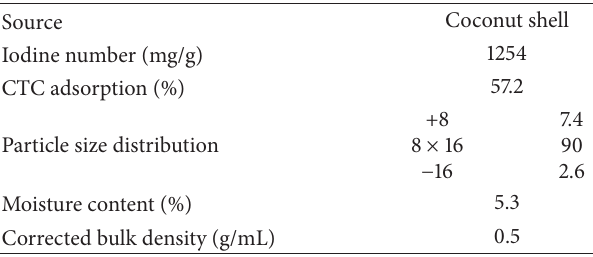
Table 1: Typical properties of GAC from Carbokarn Co., Ltd.,